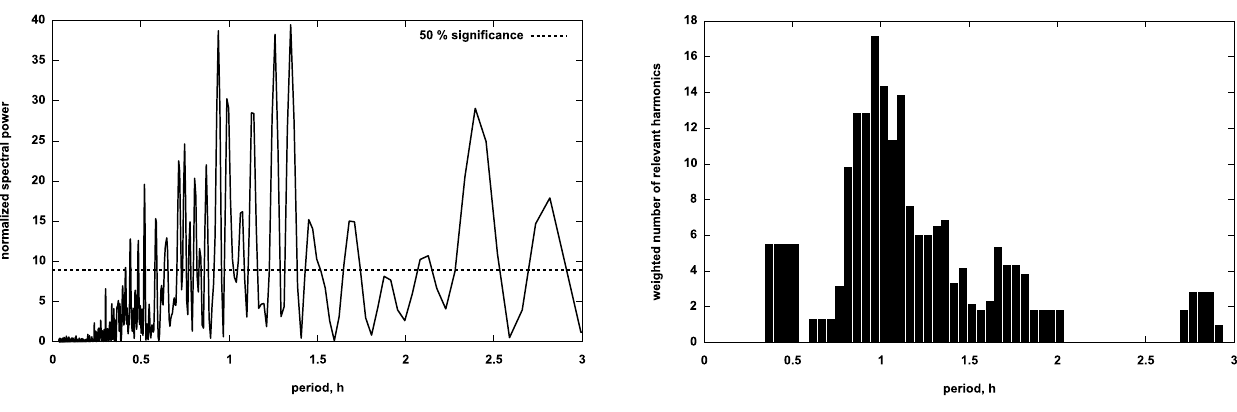
Fig. 6. Histogram of the dominant periods on 6 May 2007 (all alti- tude levels and time steps